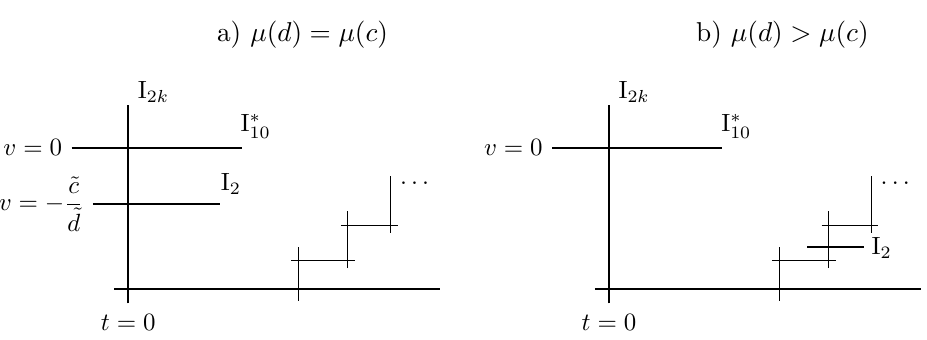
Figure 3. Schematic representation of blow-ups and intersections of characteristic